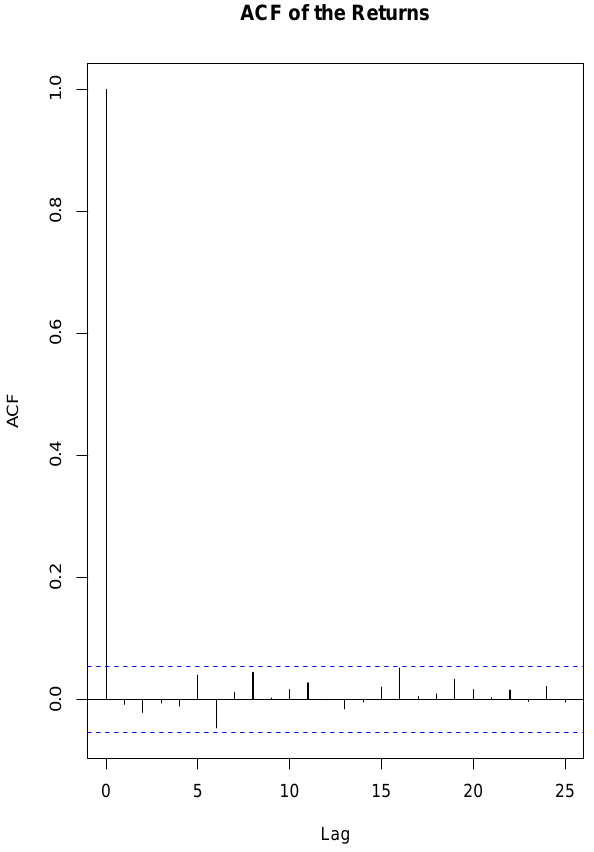
Figure 7. This figure represents the ACF of the daily returns of the Tesla share. As depicted, no serial correlations have been